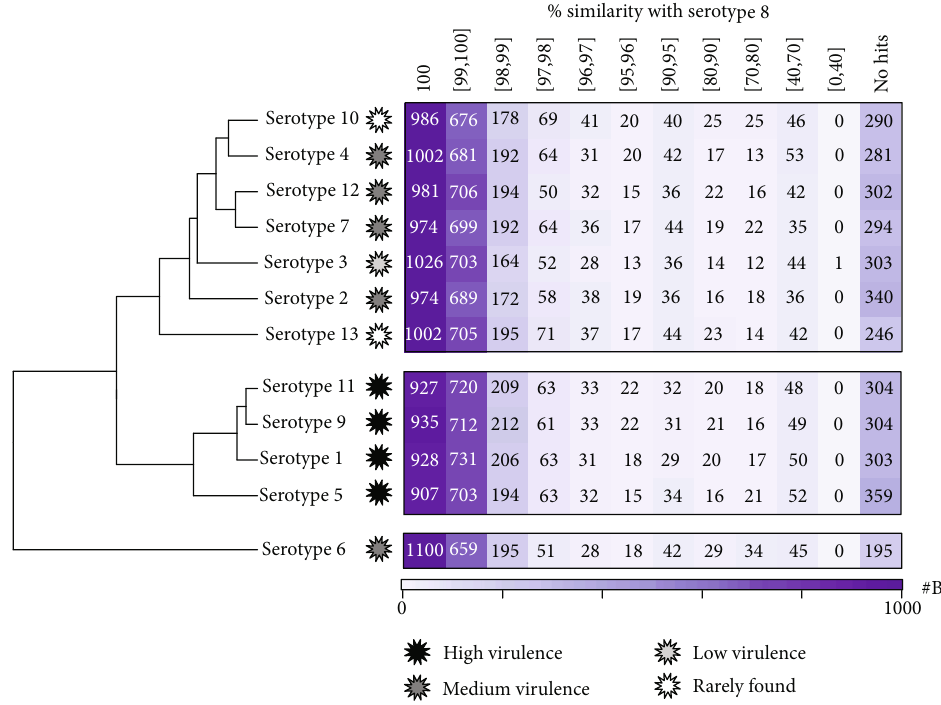
Figure 1: Analysis of similarity between predicted amino acid sequences of A. pleuropneumoniae serotype 8 and the other serotypes. The protein-coding sequences were clustered according to similarity in percentages to serotype 8. The serotypes were also characterized in relation to